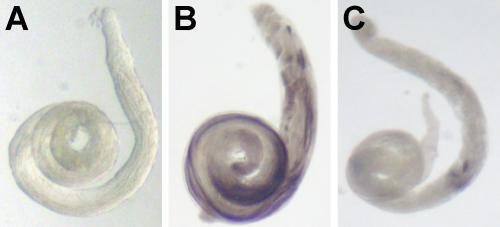
Reporter Gene Expression in TestisTestes were dissected and incubated with S-GAL, which forms a black precipitate in the presence of β-galactosidase. Shown are testes from y w males (negative control) (A), y w males with an autosomal insertion of P[wFl-ocn-lacZ] (B), and y w males with an X-linked insertion of P[wFl-ocn-lacZ] (C). Staining was performed in parallel for the same length of time. The strongest signal is in the proximal region of the autosomal-insert testis. Note that weak staining is visible in the proximal region of the X-insert testis.